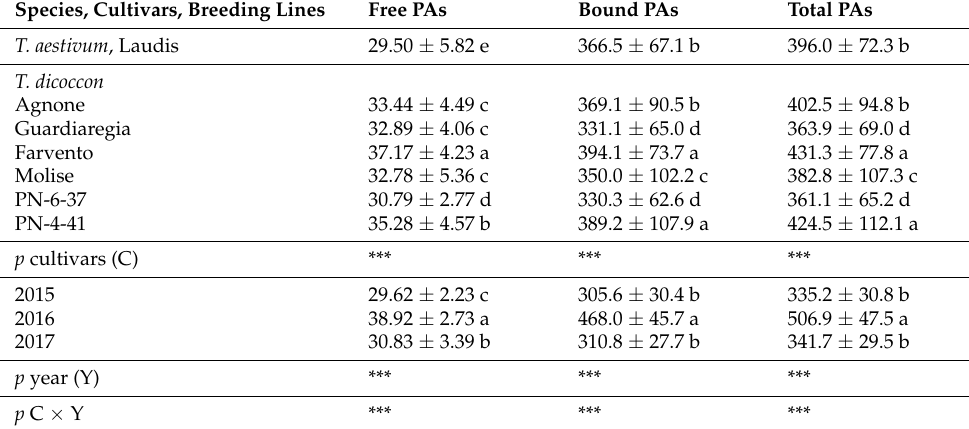
Table 3. Effect of wheat cultivars and growing years on the sum of analysed phenolic acids (PAs) concentration ( µ g g − 1 DM) in whole-grain meal.